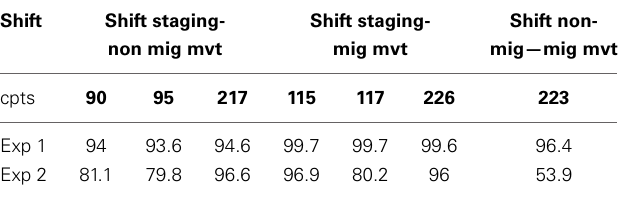
Table 2 | Performances (in %) of the PELT algorithm at detecting exactly the 7 expected change points (cpts, in bold: positions of the cpts within the year-long simulated tracking) in simulation Experiments 1 and 2 (Exp 1, Exp